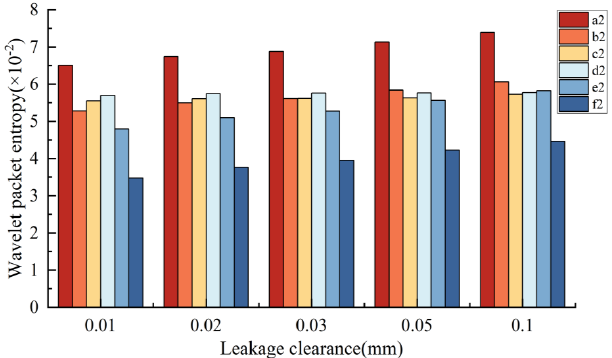
Figure 20. Fault feature of leakage in speed regulating valve.